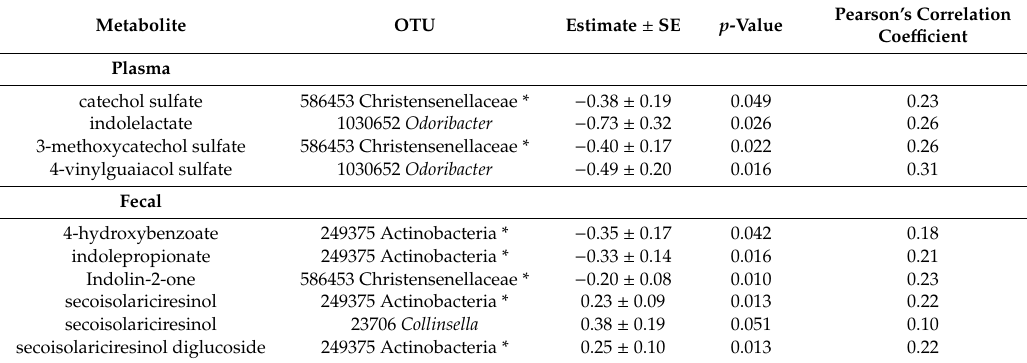
Table 8. Correlations among plasma and fecal metabolites and operational taxonomic units in the fecal microbiome of dogs with early renal disease fed the control, low soluble fiber plus betaine, and high soluble fiber plus betaine